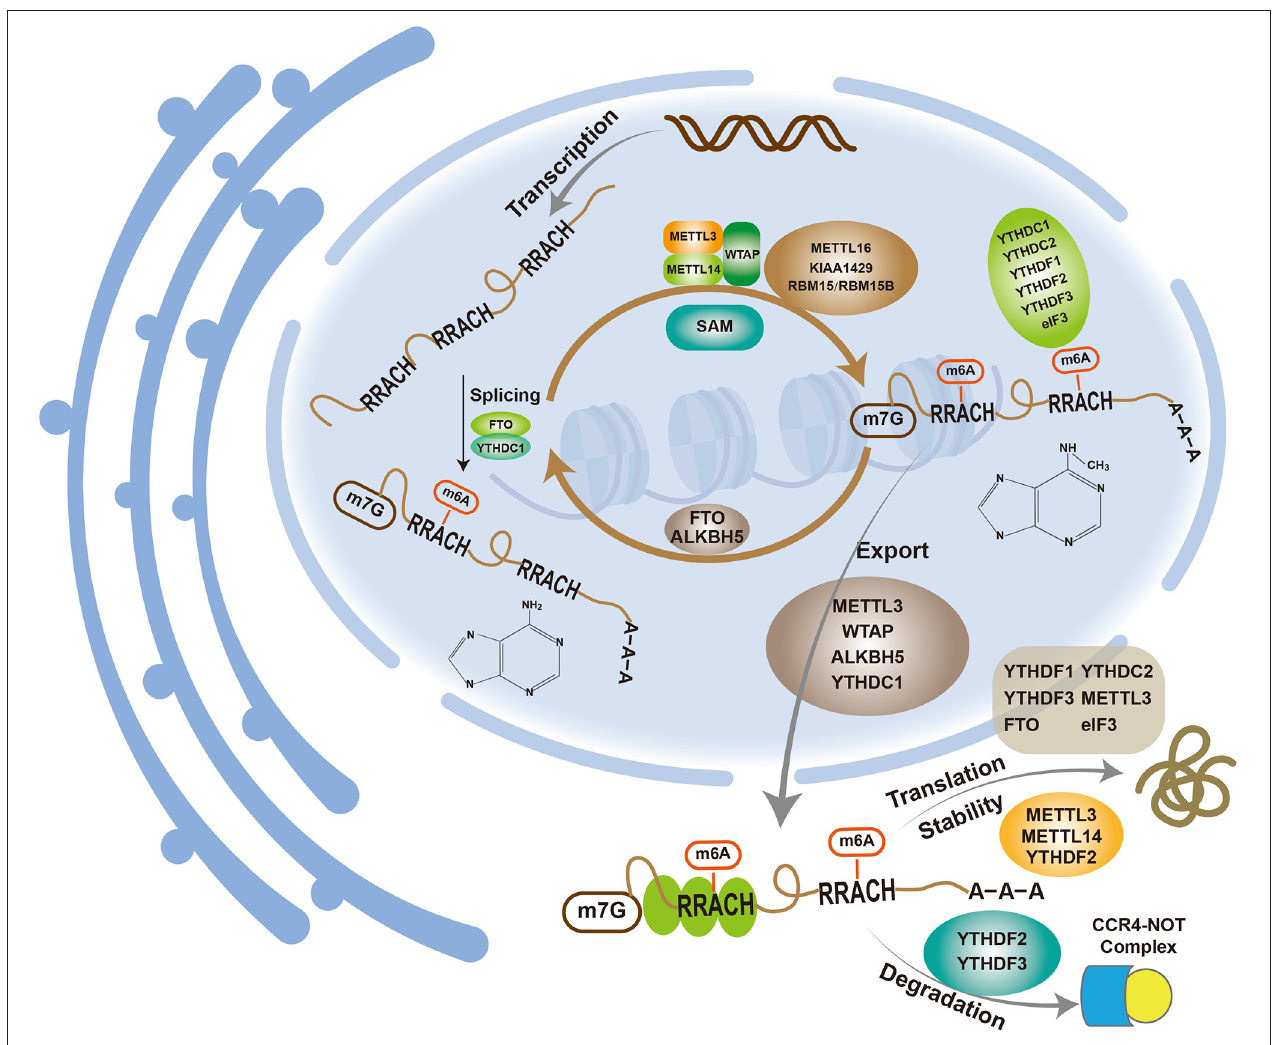
FIGURE 1 | m6A participates in various metabolic processes related to